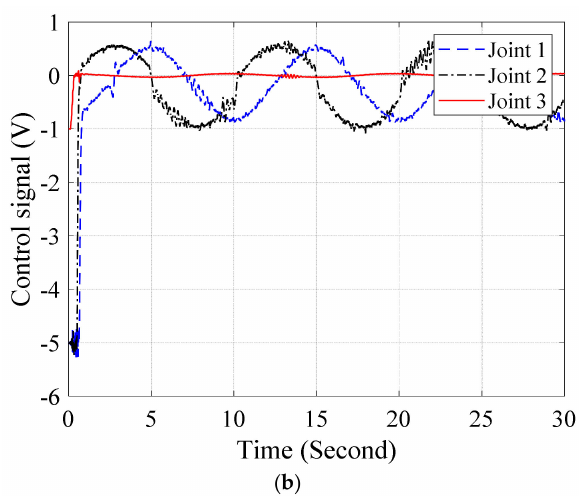
Figure 12. Control efforts of ( a ) BSMC and ( b ) Proposed control without load.